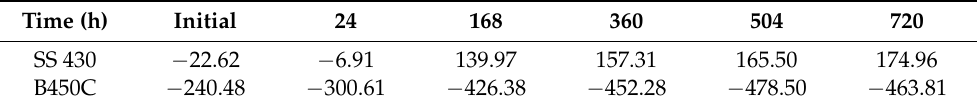
Table 4. Change in time of the corrosion potential values at open circuit potential (mV vs. SHE) of SS 430 and carbon steel B450C immersed in chloride-containing (5 g L − 1 NaCl) cement extract solutions for 720 h (30 days).